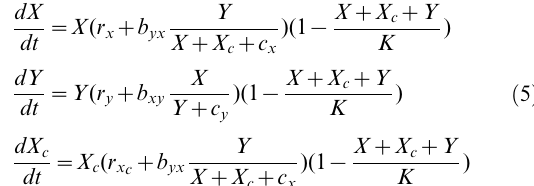
Figure 1. Trade-off between the cost of cooperation and the benefit to the recipient determines cross-feeding success. Whether cross-feeding is favoured at intermediate densities depends on: A . the slope of the trade-off function with cross-feeding more easily selected for { r shallow slopes; B . the values of the cost ( r x x ) and the benefit ( b xy ) of cross-feeding with cross-feeding more easily selected for high r x c c b xy ; C . the value of the intrinsic growth parameters ( r y , r x , r x ) with cross-feeding more easily selected for low r y , r x c lines denote cases where cross-feeding is favoured while red lines denote cases where cross-feeding is not favoured. population densities X c always does better than X because r xc w r x